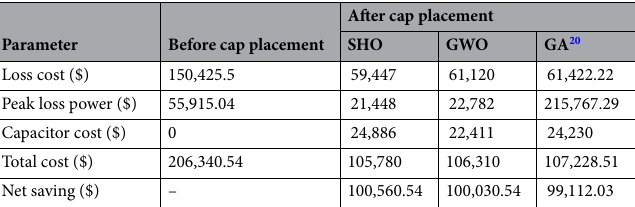
Table 6. Different cost sections in the 24-bus network before and after the capacitor placement with cosφ = 1.